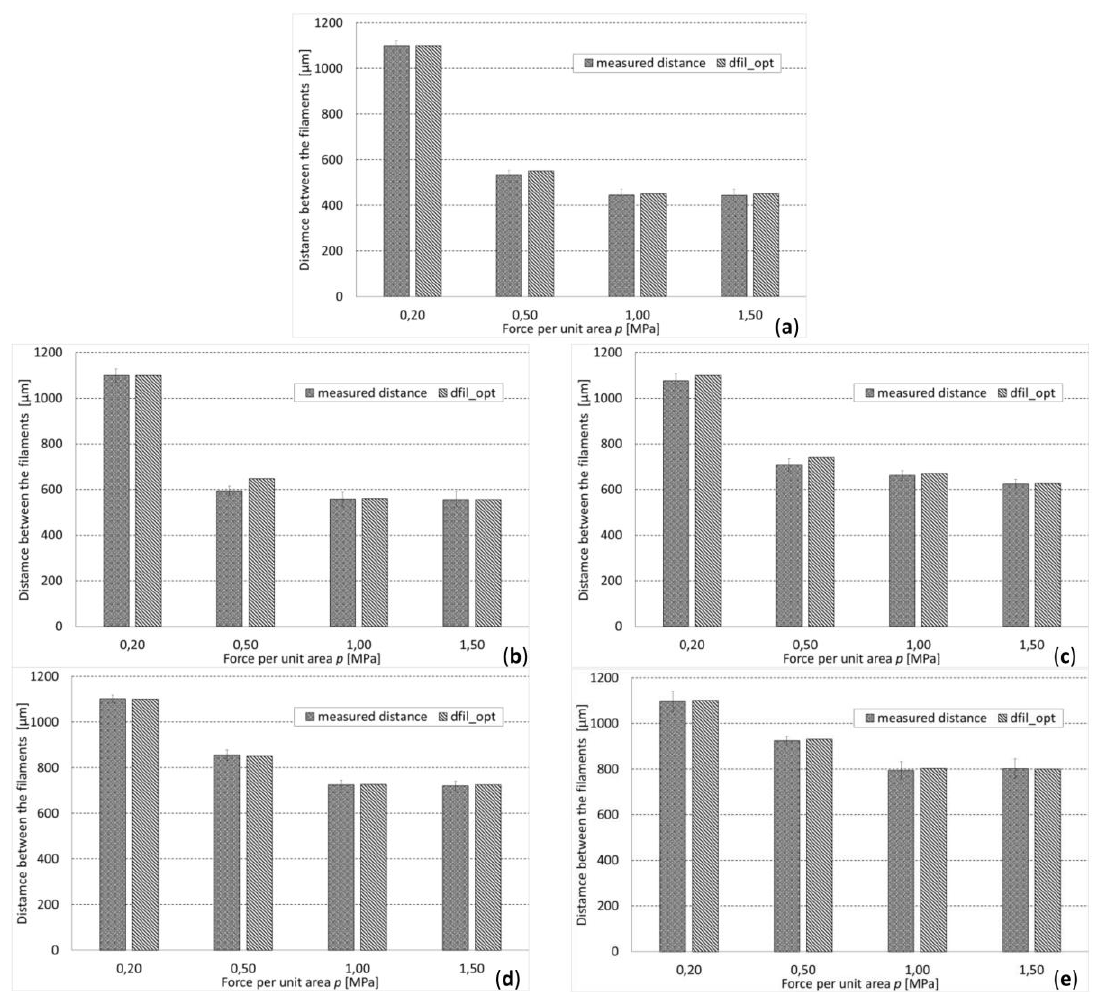
Figure 9. Comparison between measured and optimized distances (between the filaments), for different diameters: ( a ) D = 400 µm, ( b ) D = 500 µm, ( c ) D = 600 µm, ( d ) D = 700 µm, ( e ) D = 800 µm.